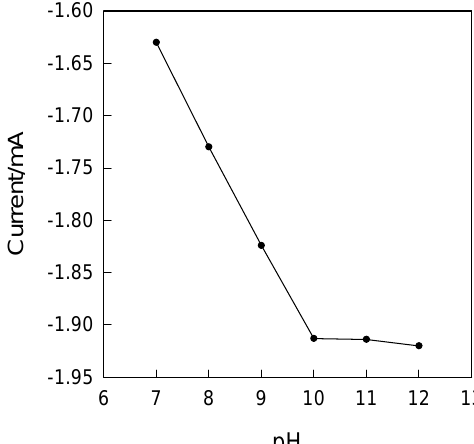
Figure 7. The effect of pH on NA oxid1zation current. NA: 10 mmol·L -1 containing 0.1 mol·L -1